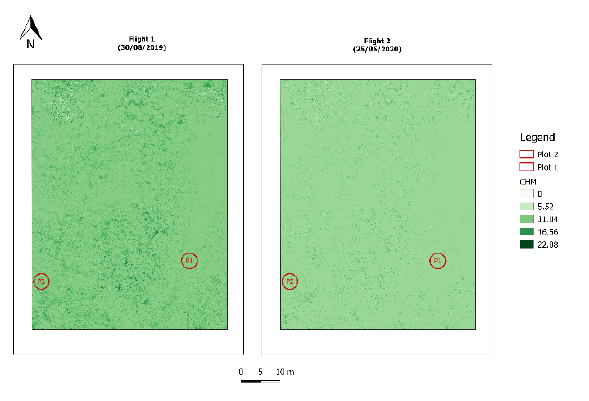
Figure 5. CHM of study area in 2019 and 2020